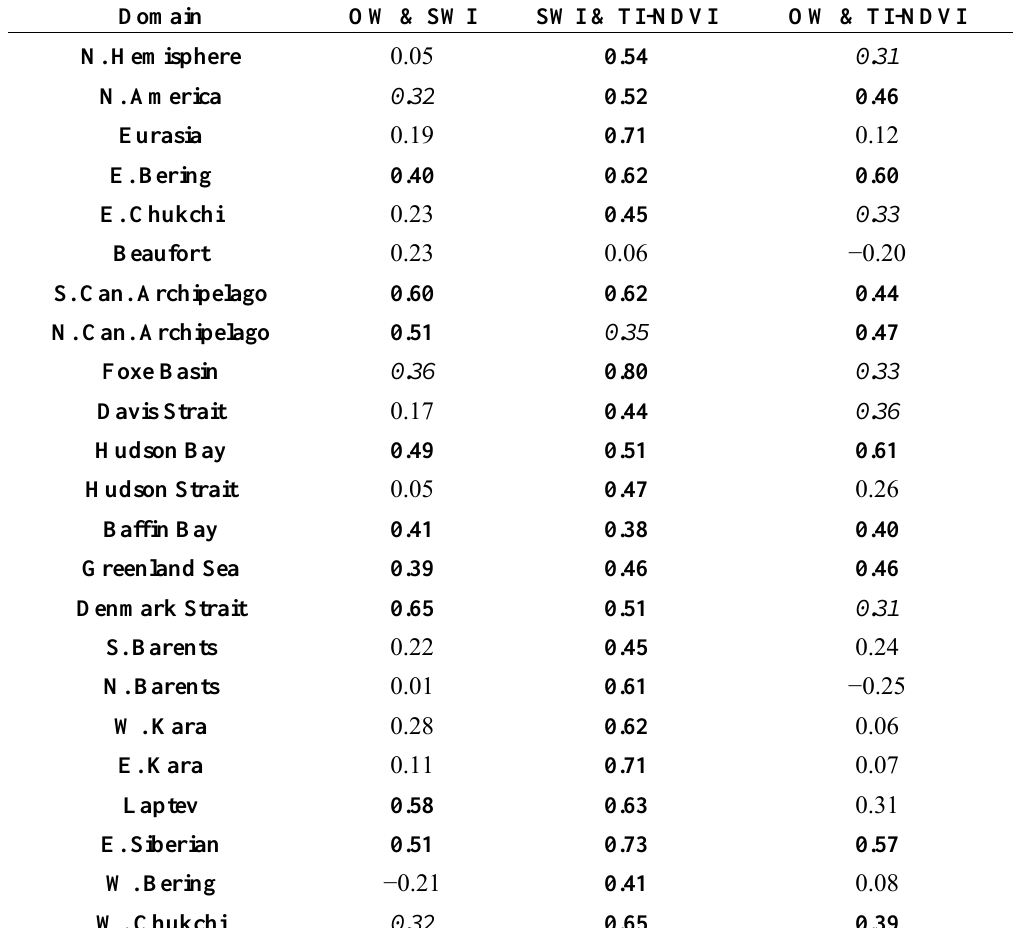
Table 1. Linearly detrended correlations among sea ice, SWI, open water (OW), TI-NDVI and MaxNDVI over 100-km ocean domain for sea ice and full tundra domain for SWI and NDVI. Bold (Italic) numbers are significant at the 95% ( 90% ) or greater level based on Student’s